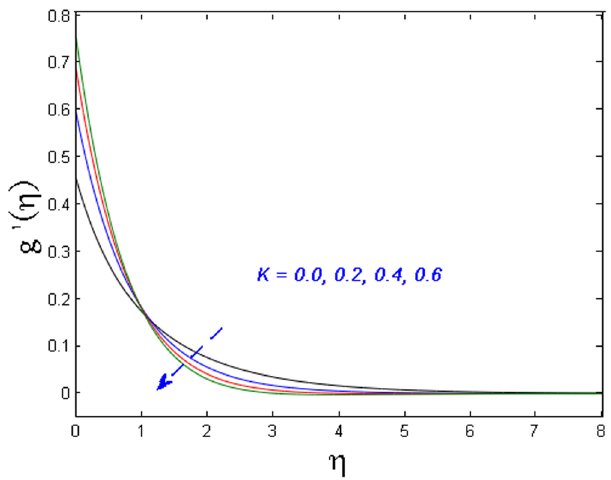
Figure 7. Effect of K on g ′ ( η